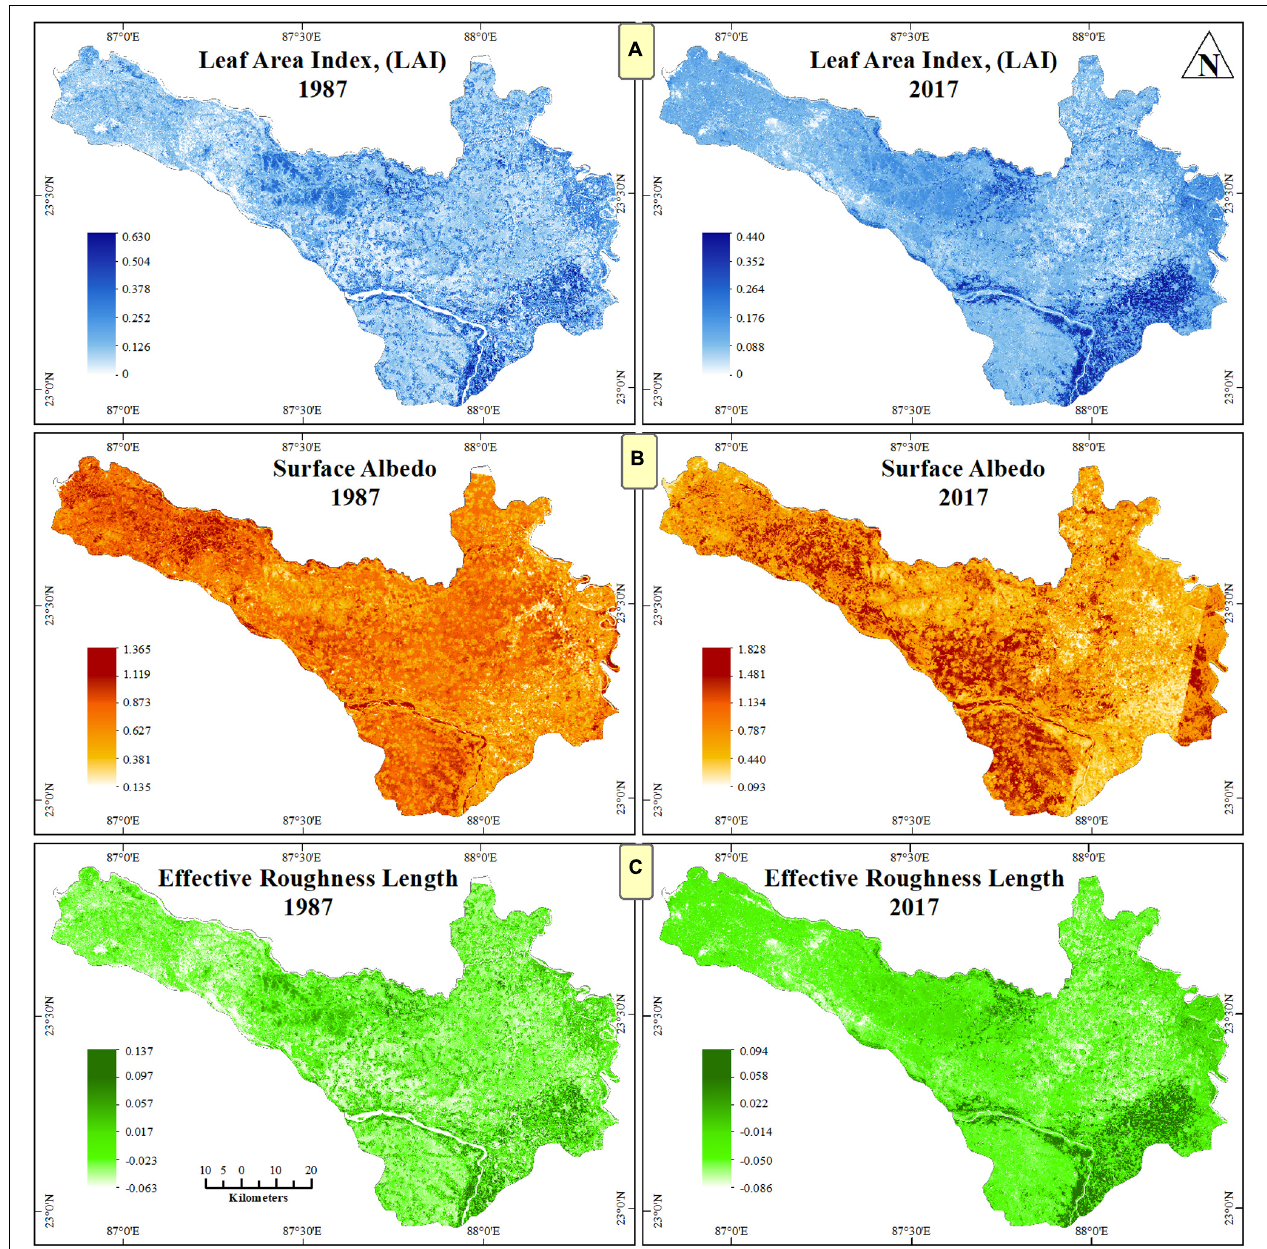
FIGURE 7 | Differences in (A) Annual mean LAI, (B) Land surface albedo ( × ), and (C) Effective roughness length (unit: m) in two difference year (1987 and 2017) using 8 days time average with 250 m spatial resolution taken from MODIS product for LAI; time average with 0.25 ◦ data sets taken from the OMI model, AVHRR data for SA and ERL (Loveland et al., 2000).